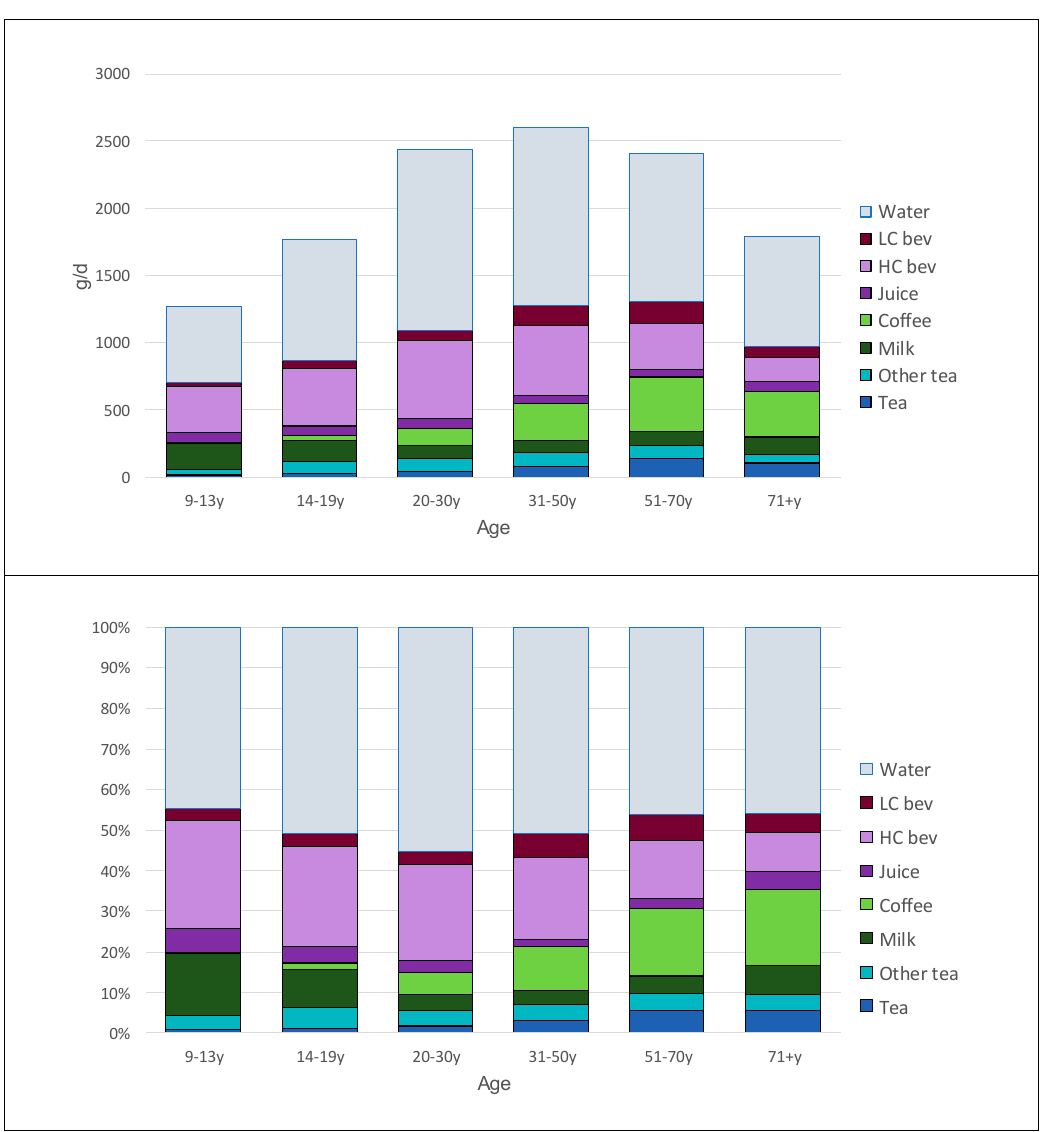
Figure 1. Tea and beverage consumption patterns by age group. Top panel shows amounts in g/day, while bottom panel shows percentages of total beverage consumption by beverage category.